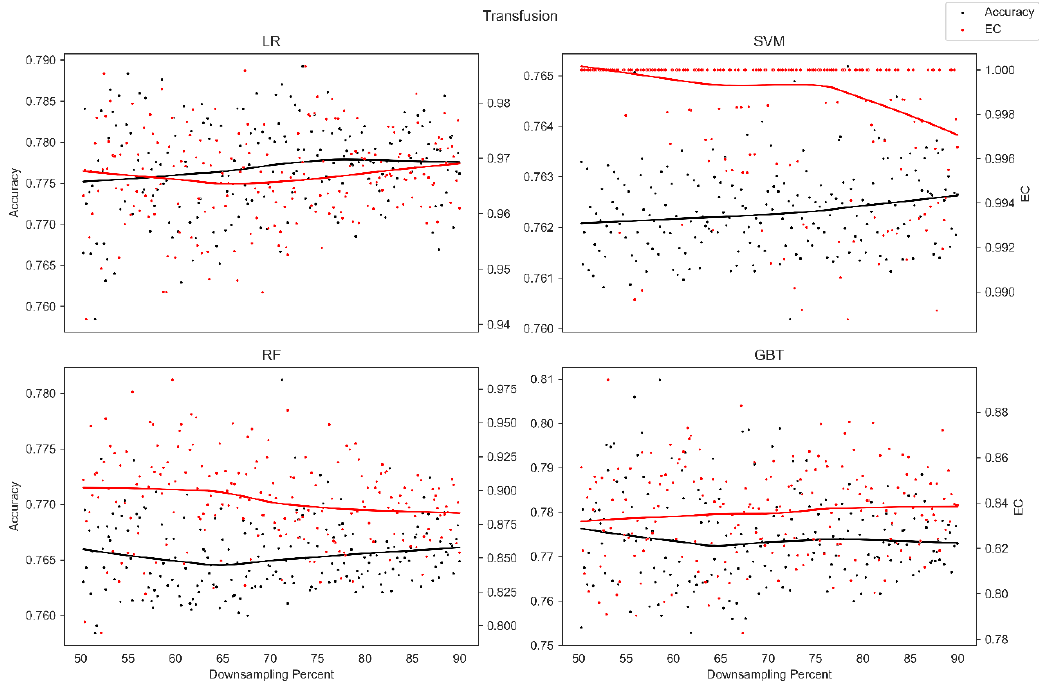
Figure 2. Average error consistency and overall accuracy vs. varying sample size percentages (down-sampled) from the Transfusion dataset. Trend lines were established with locally weighted regression and smoothing [25].